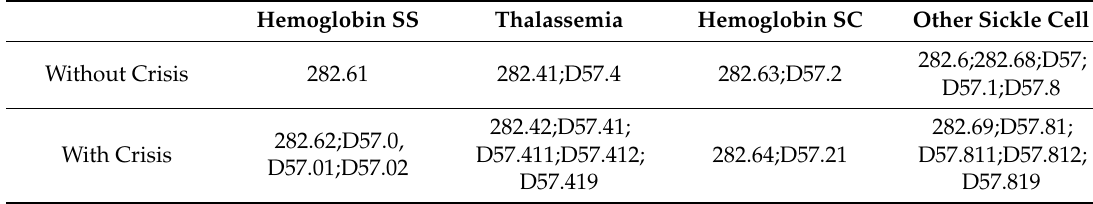
Table 1. ICD Codes used to Identify Patients with Sickle Cell